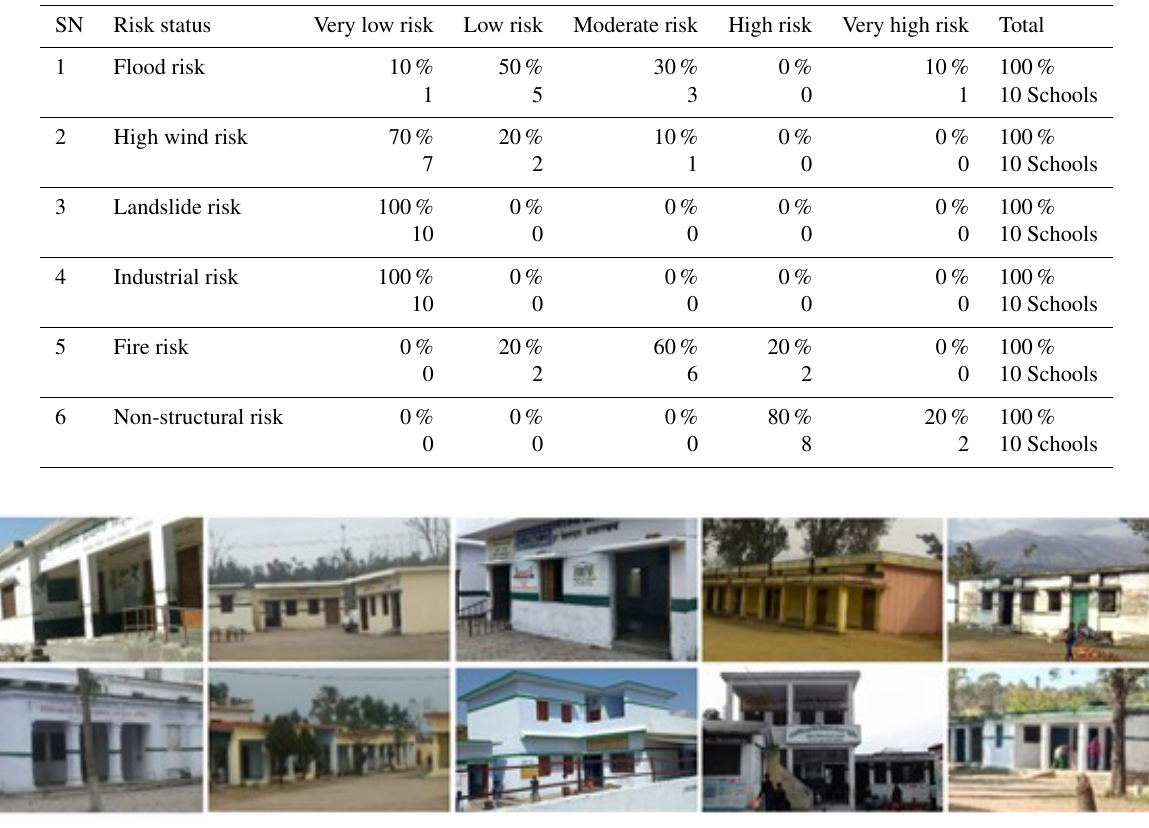
Table 7. Result of multi-hazards of 10 schools through the proposed form.